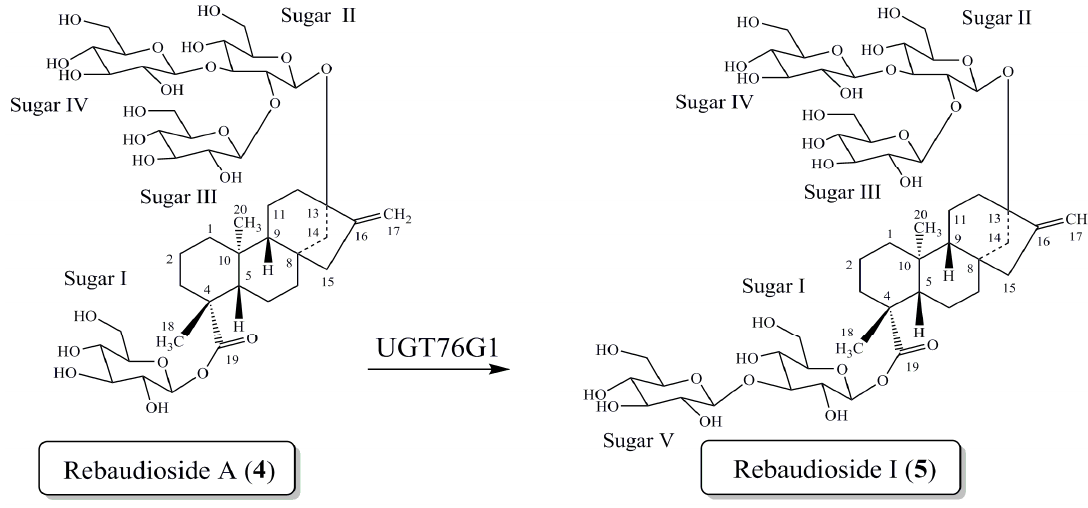
Figure 3. HPLC chromatogram for the bioconversion of rebaudioside I from rebaudioside A.